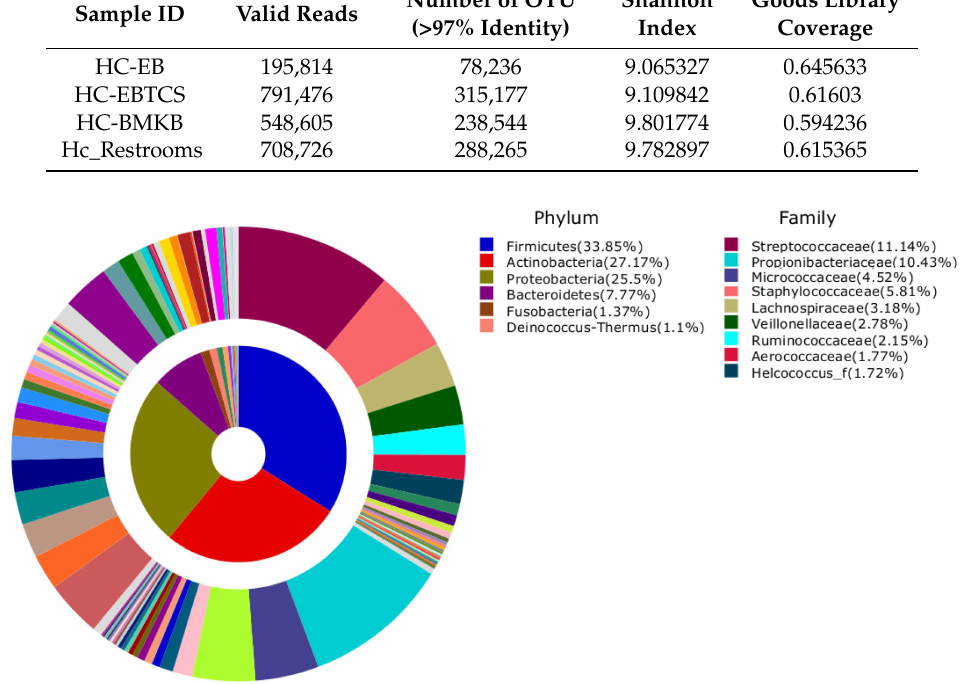
Figure 1. Average composition of bacteria from all samples (inner area: Phylum, outer area: Family). Phyla and Families with more than 1% of their proportion were represented.